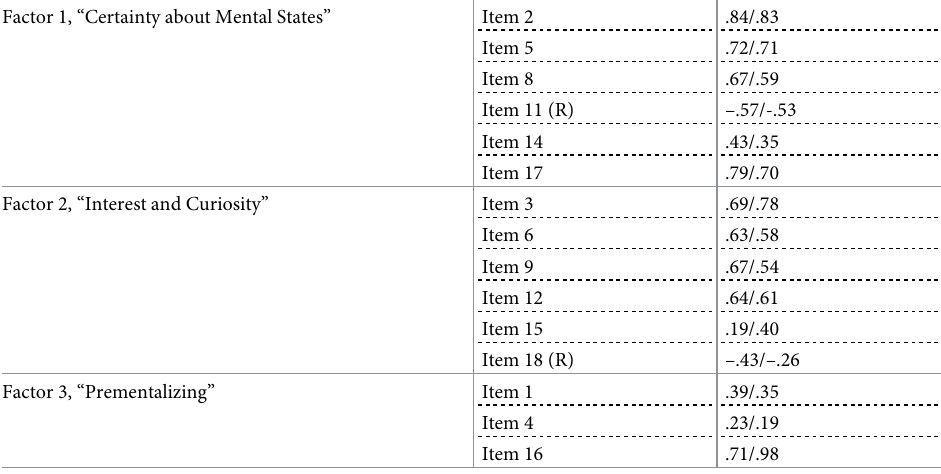
Results of the MGCFA on the PRFQ-I are presented in Table 3. The MGCFA showed an excel- lent fit for the unconstrained model, indicating configural invariance, suggesting that the fac- tor structure provided a good fit across the two groups. The CFI and RMSEA differences between models M0 and M1 were below the suggested thresholds, and the Δχ 2 was insignifi- cant ( p = .335), indicating metric invariance, i.e. equivalence of factor loadings, indicating that each item contributes similarly to its latent construct across groups. When comparing the models M1 and M2 for scalar invariance testing, the Δ CFI and Δ RMSEA and overall model fit indices met the stated criteria; however, the Δχ 2 was significant at the .05 level ( p = .014). As the majority of the fit indices were within the specified limits, this suggested measurement Table 3. The 15-item infant version of the Parental Reflective Functioning Questionnaire (PRFQ-I) and standard- ized loadings from the confirmatory factor analysis, with mothers with PPD (left, n = 237), and mothers without PPD (right, n =